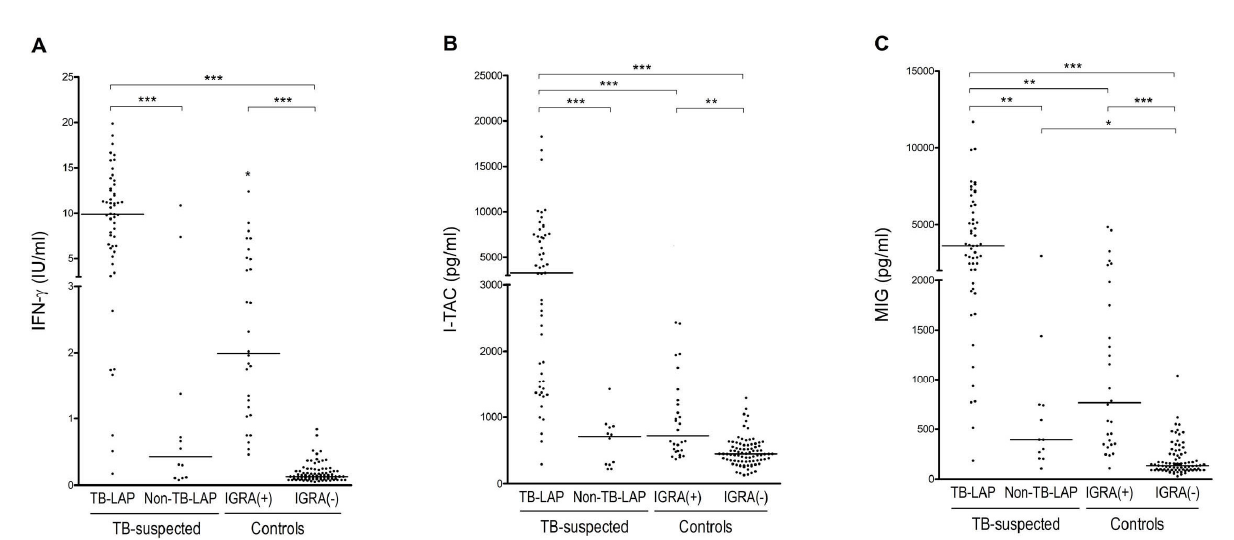
Figure 2. Comparison of tuberculosis-antigen-stimulated ( A ) interferon (IFN)- γ , ( B ) IFN-inducible T cell α chemoattractant (I-TAC), and ( C ) monokine induced by IFN- γ MIG) levels among all tuberculous lymphadenopathy (TB-LAP) patients ( n = 53), non-tuberculous lymphadenopathy (Non-TB-LAP) patients, and IFN- γ release assay (IGRA)-positive and -negative control groups. Horizontal lines represent median values. * p < 0.05; ** p < 0.01; *** p < 0.001 (Kruskal–Wallis analysis with Dunn’s comparison